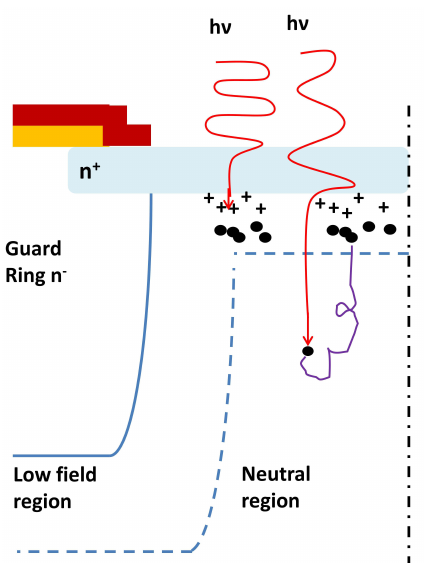
Figure 4: While photogenerated carriers close to the multiplica- tion region contribute to a narrow response pulse, photogenerated carriers in the bulk lead to a diffusion tail which limits the timing resolution of planar bulk Si SPADs. Adapted from [36].